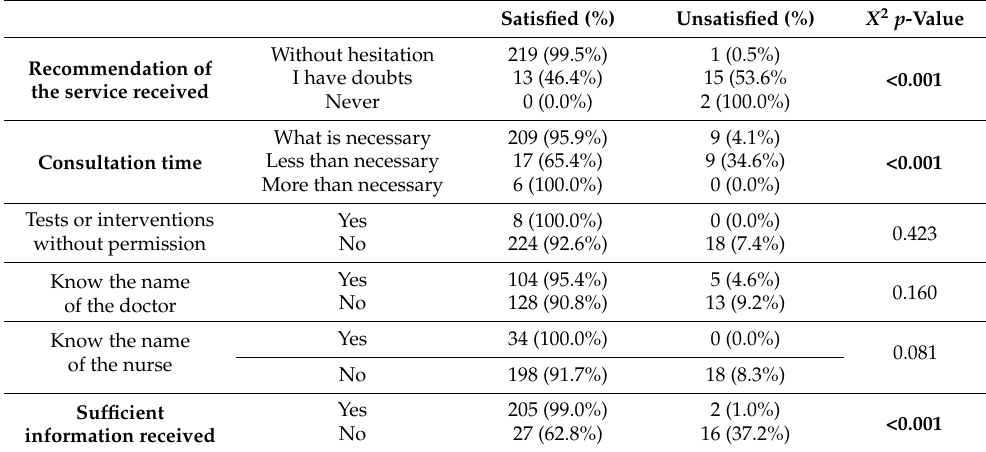
Table 4. Analysis of the influence of different variables on overall satisfaction.